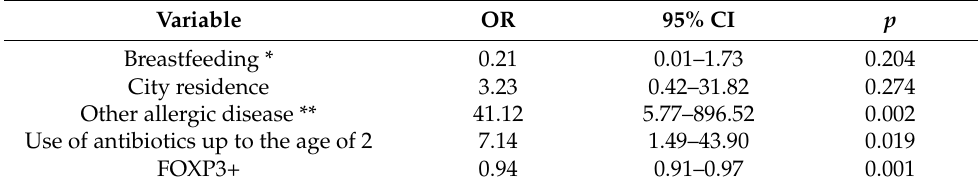
Figure 1. The covariates for multivariate logistic regression. Table 3. Multivariate logistic regression for asthma risk within the cohort of children included in the study (N = 85).